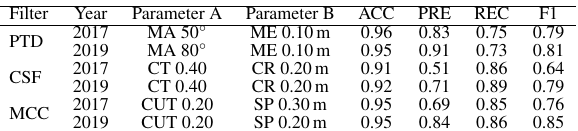
Figure 6. F1 scores for classifying ground points with the PTD filter (a,d), the CSF (b,e) and the MCC filter (c,f) for the selected vegetated test area. Results are shown for the 3D point clouds acquired in 2017 (a,b,c) and 2019 (d,e,f). Table 3. Performance metrics for the identified best parameter set for each technique applied to the 3D point clouds acquired in 2017 and 2019. Acronyms are defined in the text.